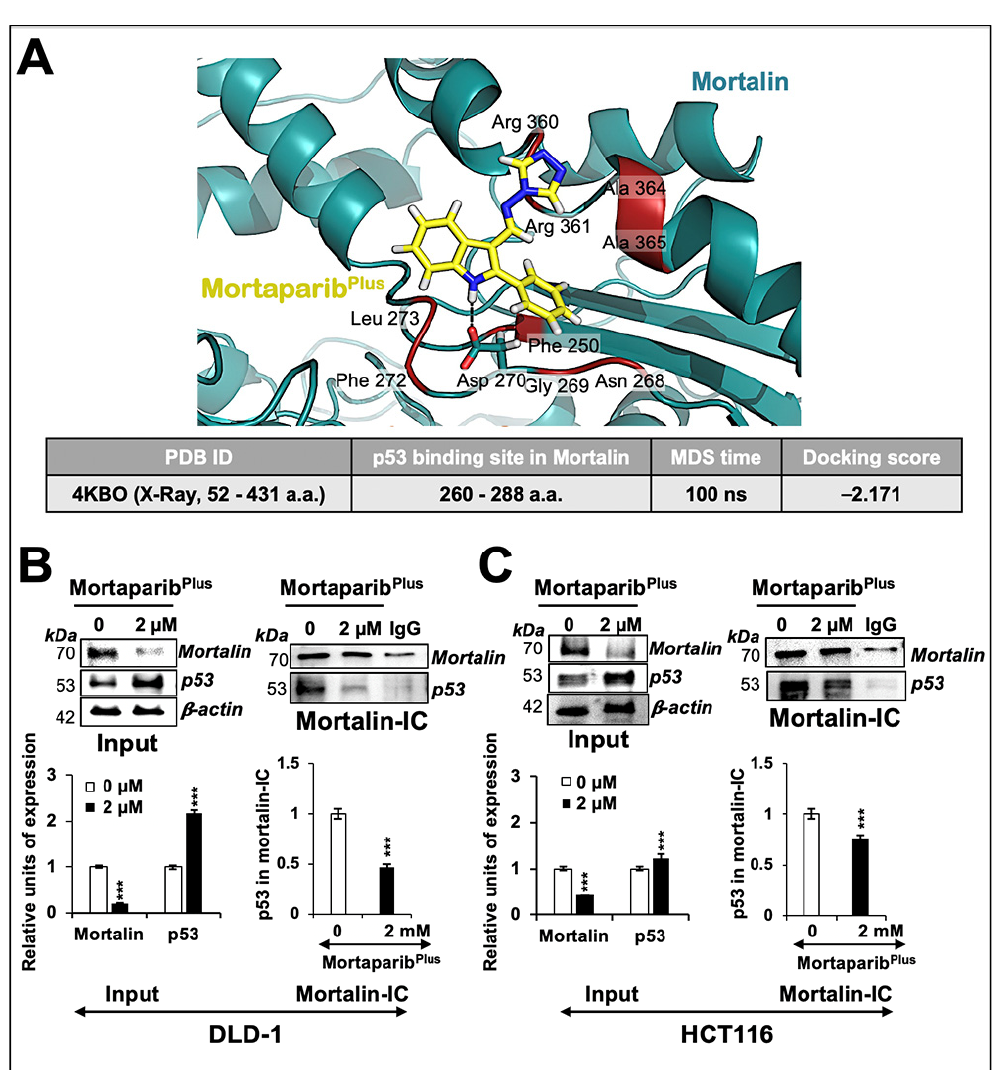
Figure 2. Mortaparib Plus abrogated the interaction of mortalin and p53 in silico and in vitro. Molecular-docking analyses showed an interaction of Mortaparib Plus with the interface of mortalin involved in p53 binding ( A ). Co-immunoprecipitation analyses using a rabbit polyclonal anti-mortalin antibody ( B , C ) showed a decrease in p53 fractions (wild type or mutant) only in mortalin complexes immunoprecipitated from Mortaparib Plus -treated (24 h) colorectal cancer cells. A decline in mortalin levels in the input non-immunoprecipitated samples from the same cell lysates was observed. The quantified data represents mean ± SD obtained from three independent biological replicates; p -values were calculated using unpaired Student’s t -test. *** < 0.001 represent significant, very significant and very very significant,